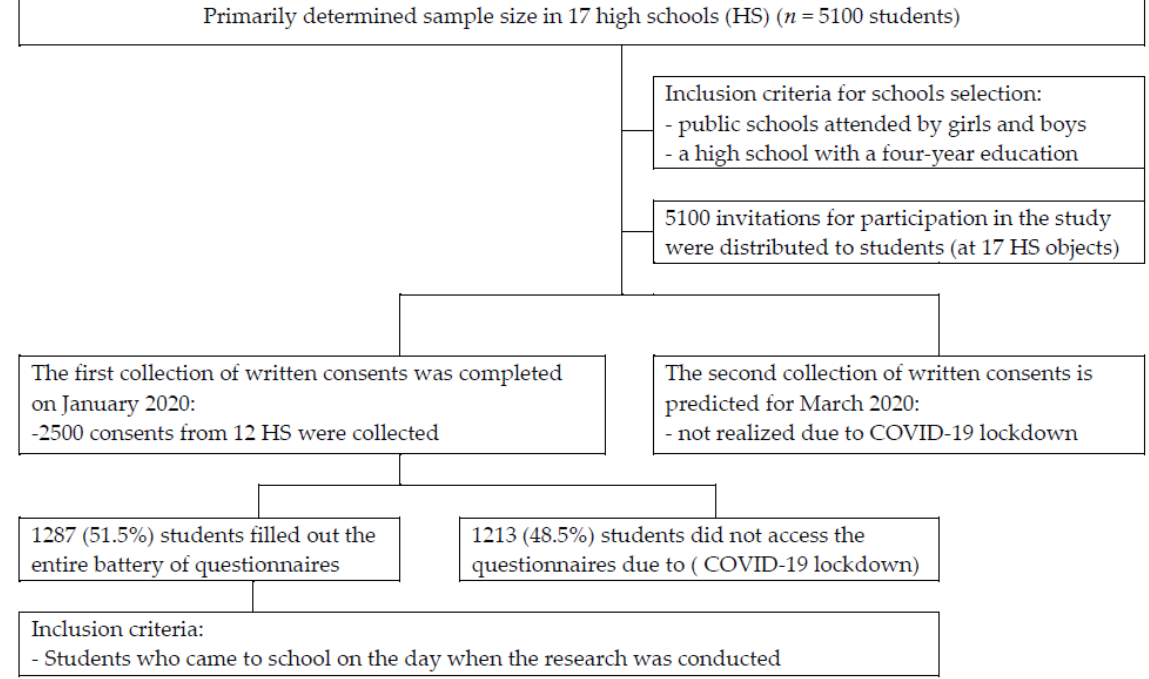
Figure 1. The process of the study group selection.